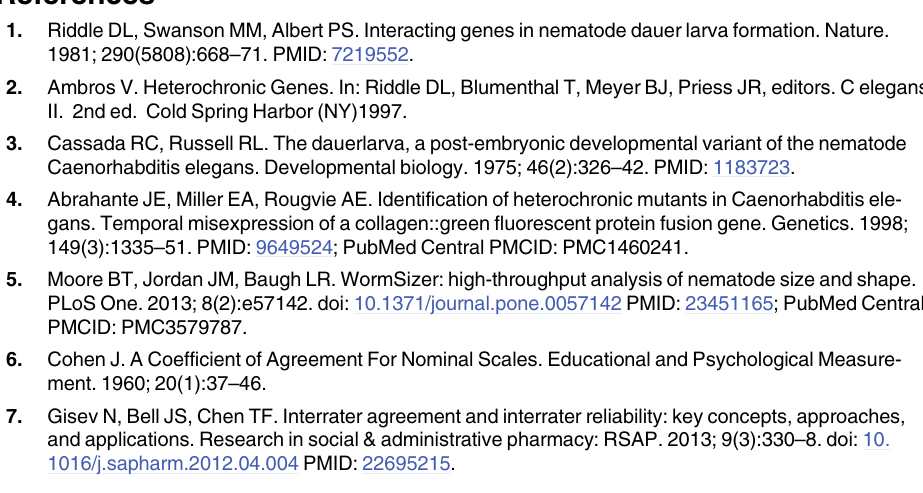
S1 Table. Primary data showing the scoring of individual worms by each rater. The numeric scores represent 1 for L1, 2 for L2, 3 for dauer, 4 for L3, and 5 for L4. (DOCX) S1 Text. OpenMX code used for model